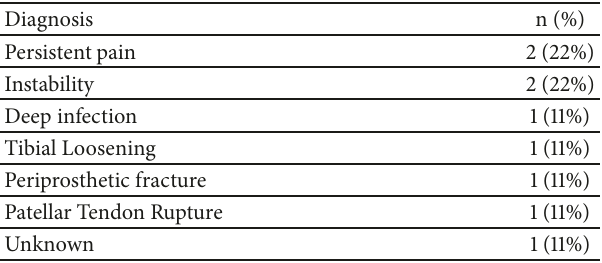
Table 3: Reasons for Revision (removal of one or more implant components).